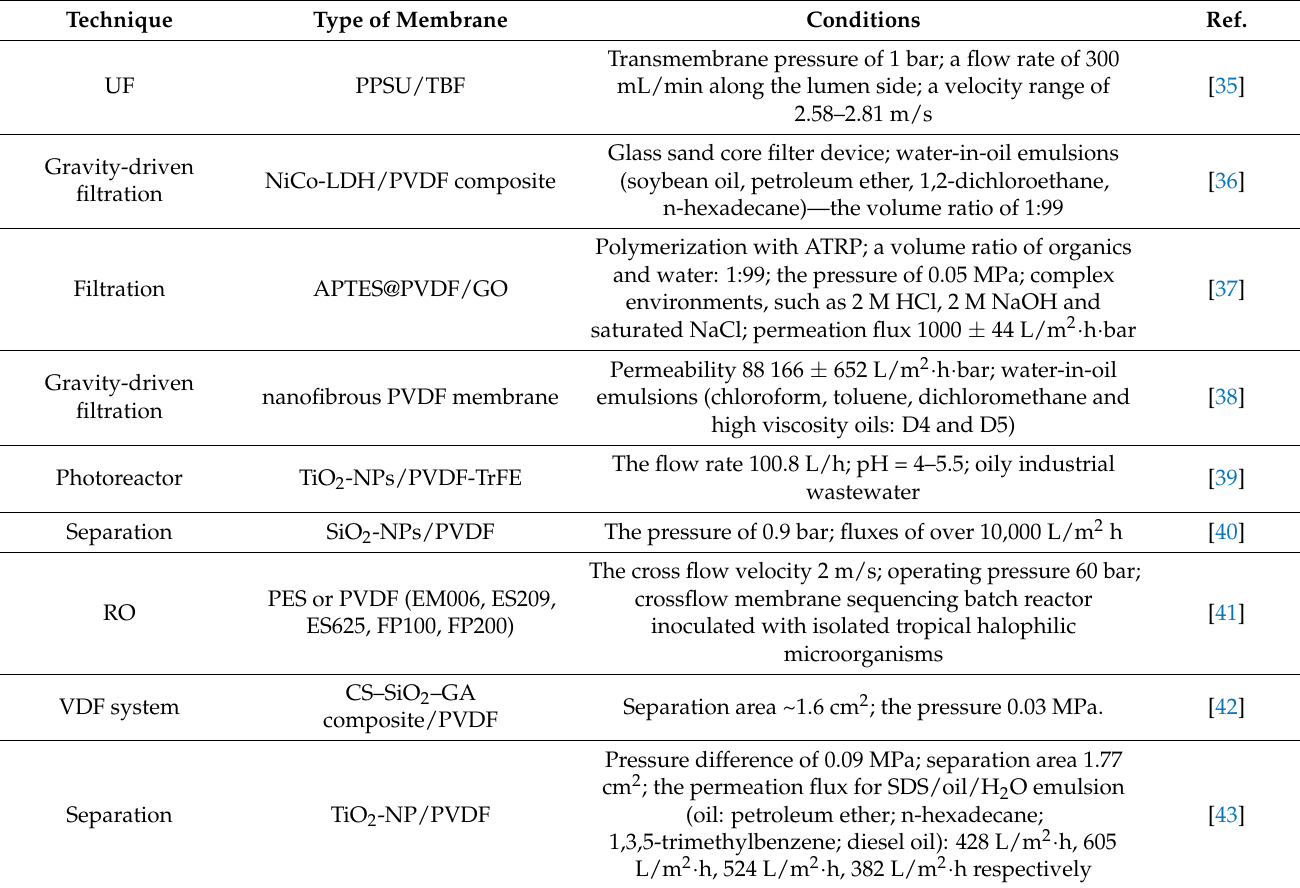
PPSU—sulfonated polyphenylenesulfone polymer; TBF—triangle-shape tri-bore hollow fiber membranes; NiCo-LDH—nickel cobalt layered double hydroxide; PVDF—the polydopamine modified polyvinylidenefluoride membrane; APTES—3-aminopropyltriethoxysilane; ATPR—atomic transfer radical polymerization; PVDF—poly(vinylidenefluoride); TrFE—trifluoro ethylene; PSH—poly(3-(N-2- methacryloxyethyl-N,N-dimethyl)ammonatopropanesultone)-co-2-hydroxyethyl methacrylate; CS—chitosan; GA—glutaraldehyde; VDF— a vacuum driven filtration system; SDS—Sodium Dodecyl